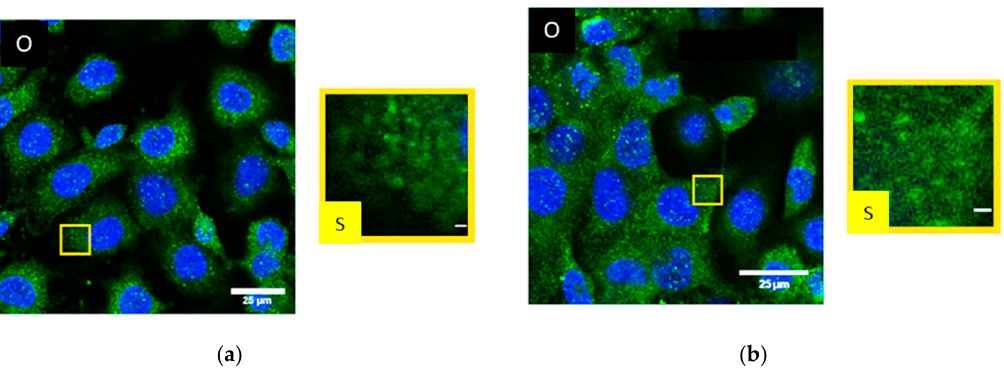
Figure 2. CLSM images of SkBr3 breast cancer cells after ( a ) NRG1 treatment for 1 h; ( b) trastuzumab treatment for 1 h; blue: Cell nucleus after Hoechst34580 staining; green: Cx43 specific antibody labelling and Alexa488 staining. (O) Overview with selected region. (S) Image section of a SkBr3 cell obtained. Scale bar 1 µ m.